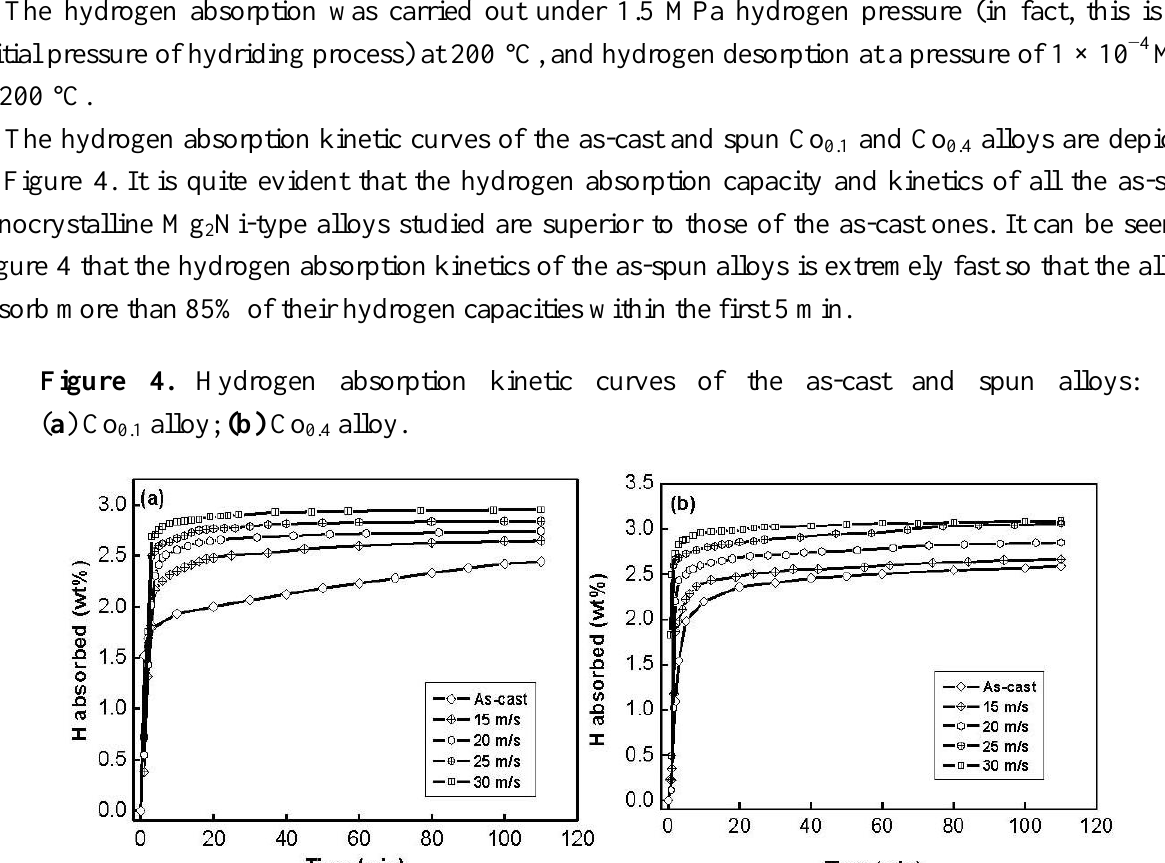
Figure 3. DSC profiles of Co